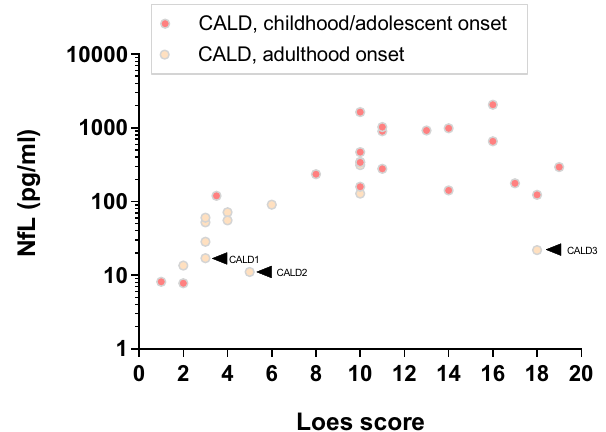
Fig. 2 Association between plasma/serum NfL and MRI score of brain lesions in CALD patients. The MRI score of location and activity of the in fl ammatory myelin destruction in CALD patients ( n = 24, including 13 childhood/adolescent CALD cases [pink fi lled circles] and 11 adult CALD cases [beige fi lled circles], median age = 17 years, total sample number = 32), according to the 34-point severity scale of Loes, was associated with NfL levels ( R 2 = 0.73, p = 0.002). Arrowheads indicate three patients with atypically mild and slowly progressive adult CALD disease course (CALD1- 3). Statistical analysis included a fi xed factor for sample type and a random ID factor as well as a linear and quadratic term for the Loes score. Source data are provided as a Source Data fi